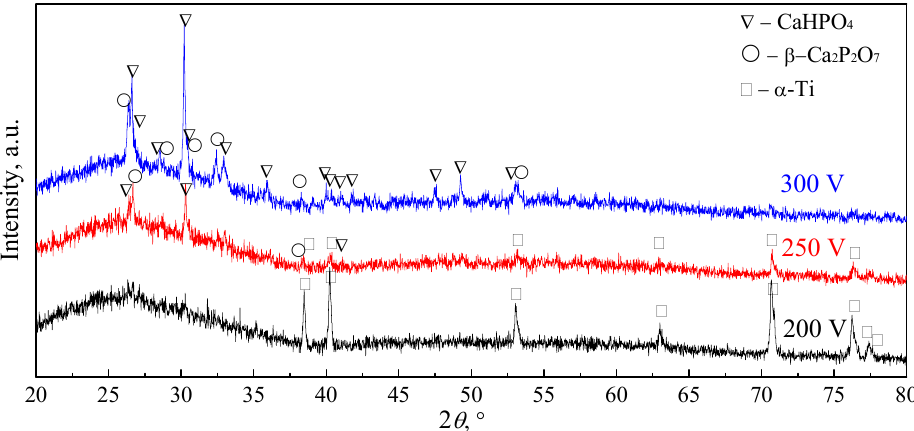
Figure 3. X-ray diffraction (XRD) patterns of the CaP coatings formed at 200 V, 250 V, and 300 V.